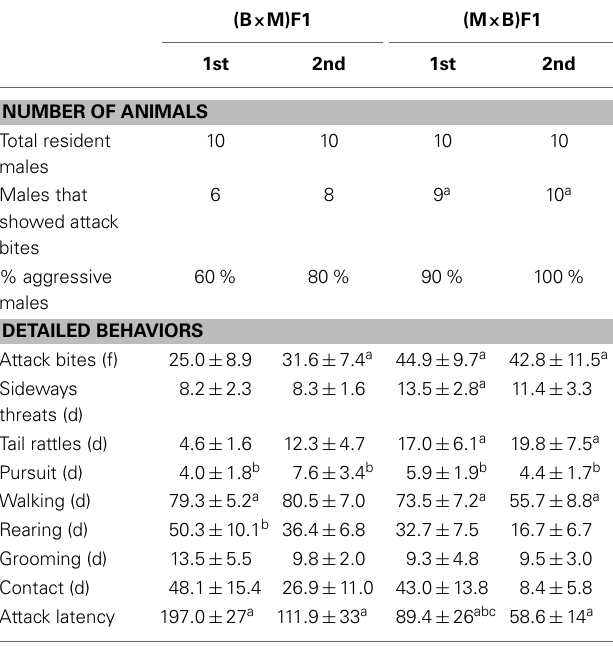
Table 2 | Resident-intruder test in reciprocal F1